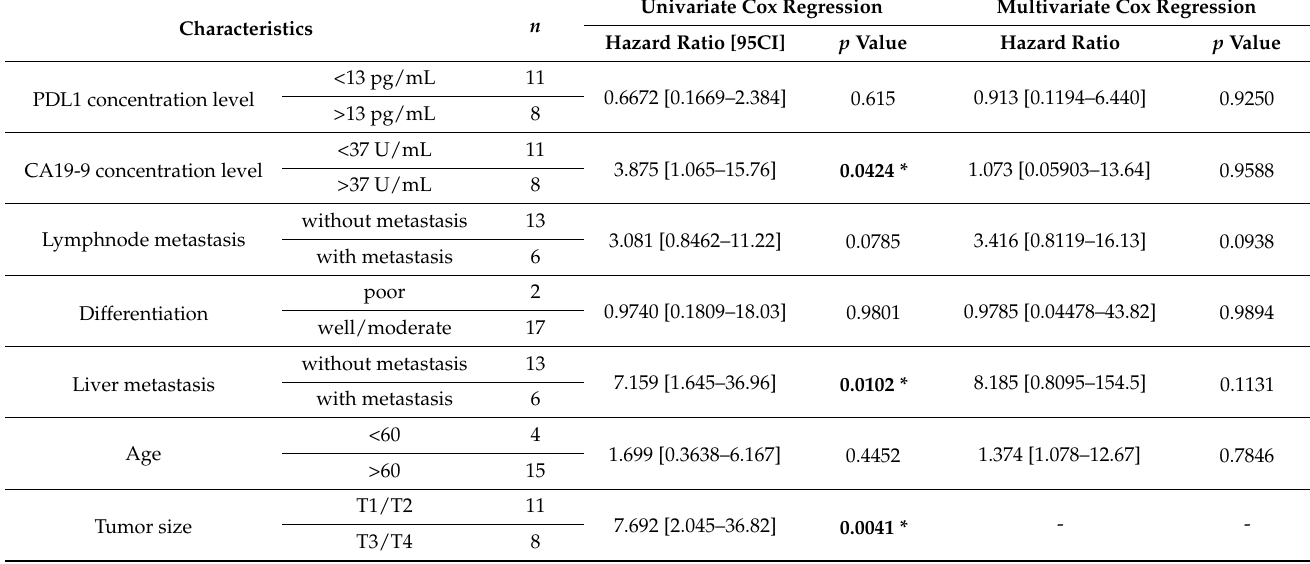
Table 2. Univariate and multivariate analyses of prognostic